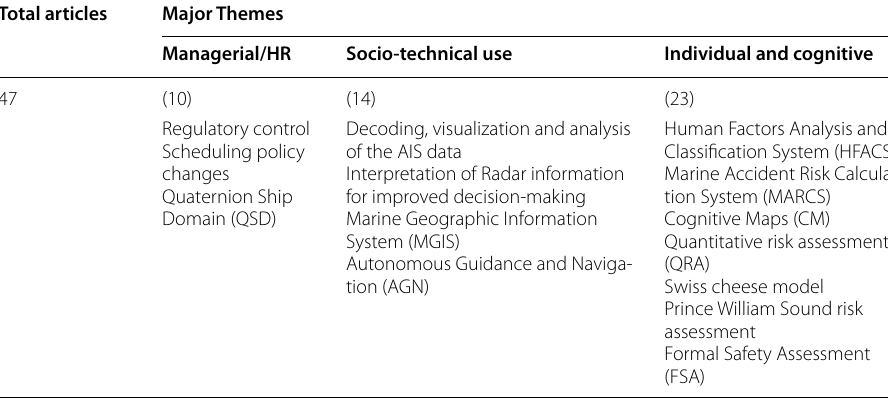
Table 7 Cluster C: main topics discussed in articles Total articles